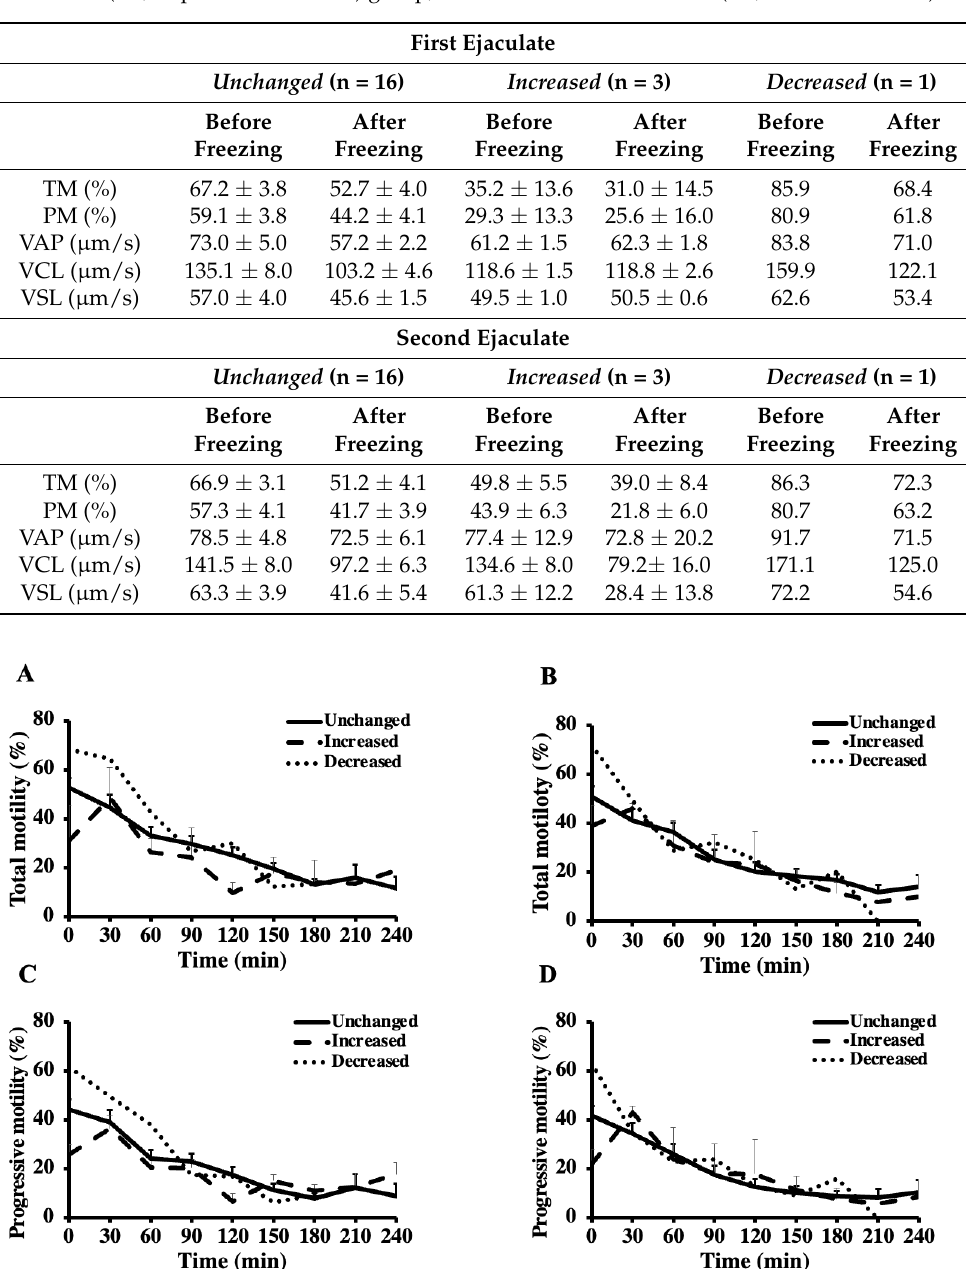
Table 13. Motility parameters of the first and second ejaculates of the season collected from breeding inactive stallions (n = 20) before and after freezing. Based on the motility parameters between the first and second ejaculates, sixteen stallions were classified as unchanged (i.e., ≤ 10% change), three stallions as increased (i.e., improvement > 10%) group, and one stallion as decreased (i.e., reduction > 10%).